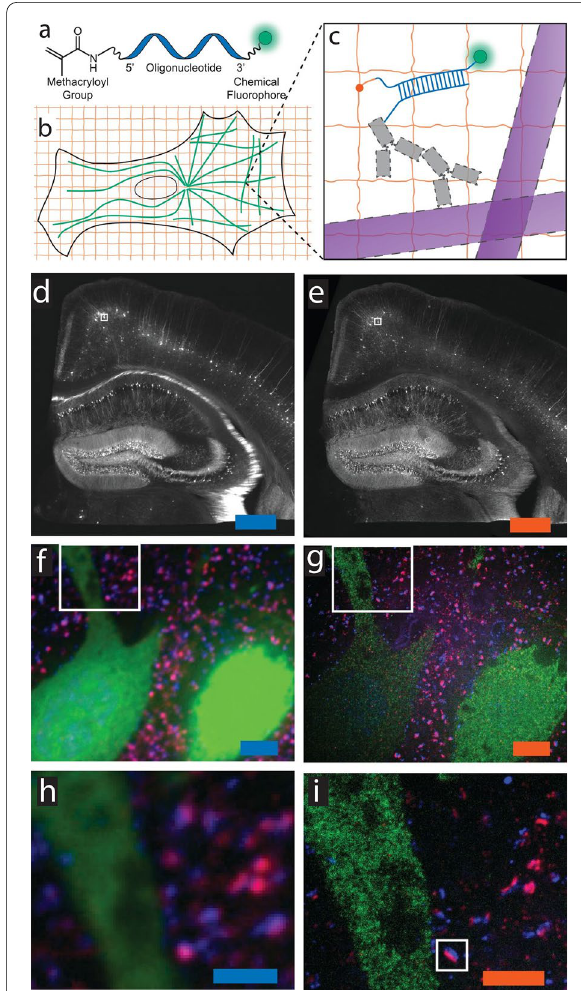
Fig. 7 Anchoring and labeling of proteins using acrydite-modified oligonucleotides (oligos) in the original ExM protocol. a Chemical structure of the acrydite-modified oligo. b Schematic of microtubules (green) and hydrogel network (orange). c The acrydite-modified oligo (shown in a ) hybridized to a oligo-bearing secondary antibody (gray, top), bound via the primary antibody (gray, bottom) to the microtubules (purple). The acrydite-oligo is incorporated into the gel (orange lines) via the methacryloyl group (orange dot) and remains anchored after the removal of the microtubules and antibodies by proteolysis (dotted lines). d Pre-expansion widefield fluorescence image of Thy1-YFP mouse brain slice. Scale bar, 500 μm. e Post-expansion widefield image of the same sample in d . Scale bar, 500 μm (2.01 mm). f , g Confocal fluorescence image of the boxed regions in d and e , respectively. Scale bars, 5